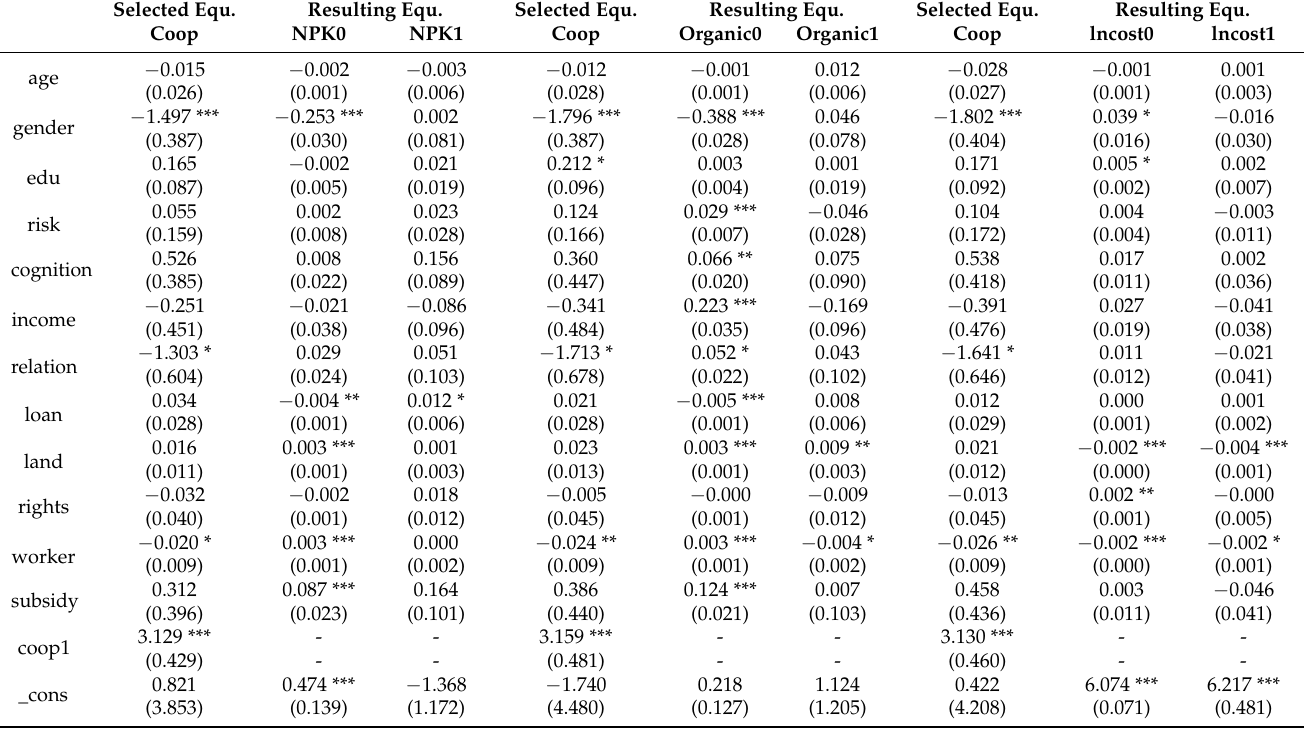
Table 3. Estimated results of joining cooperatives on the reduction of fertilizer application by smallholder farmers (endogenous transformation model).